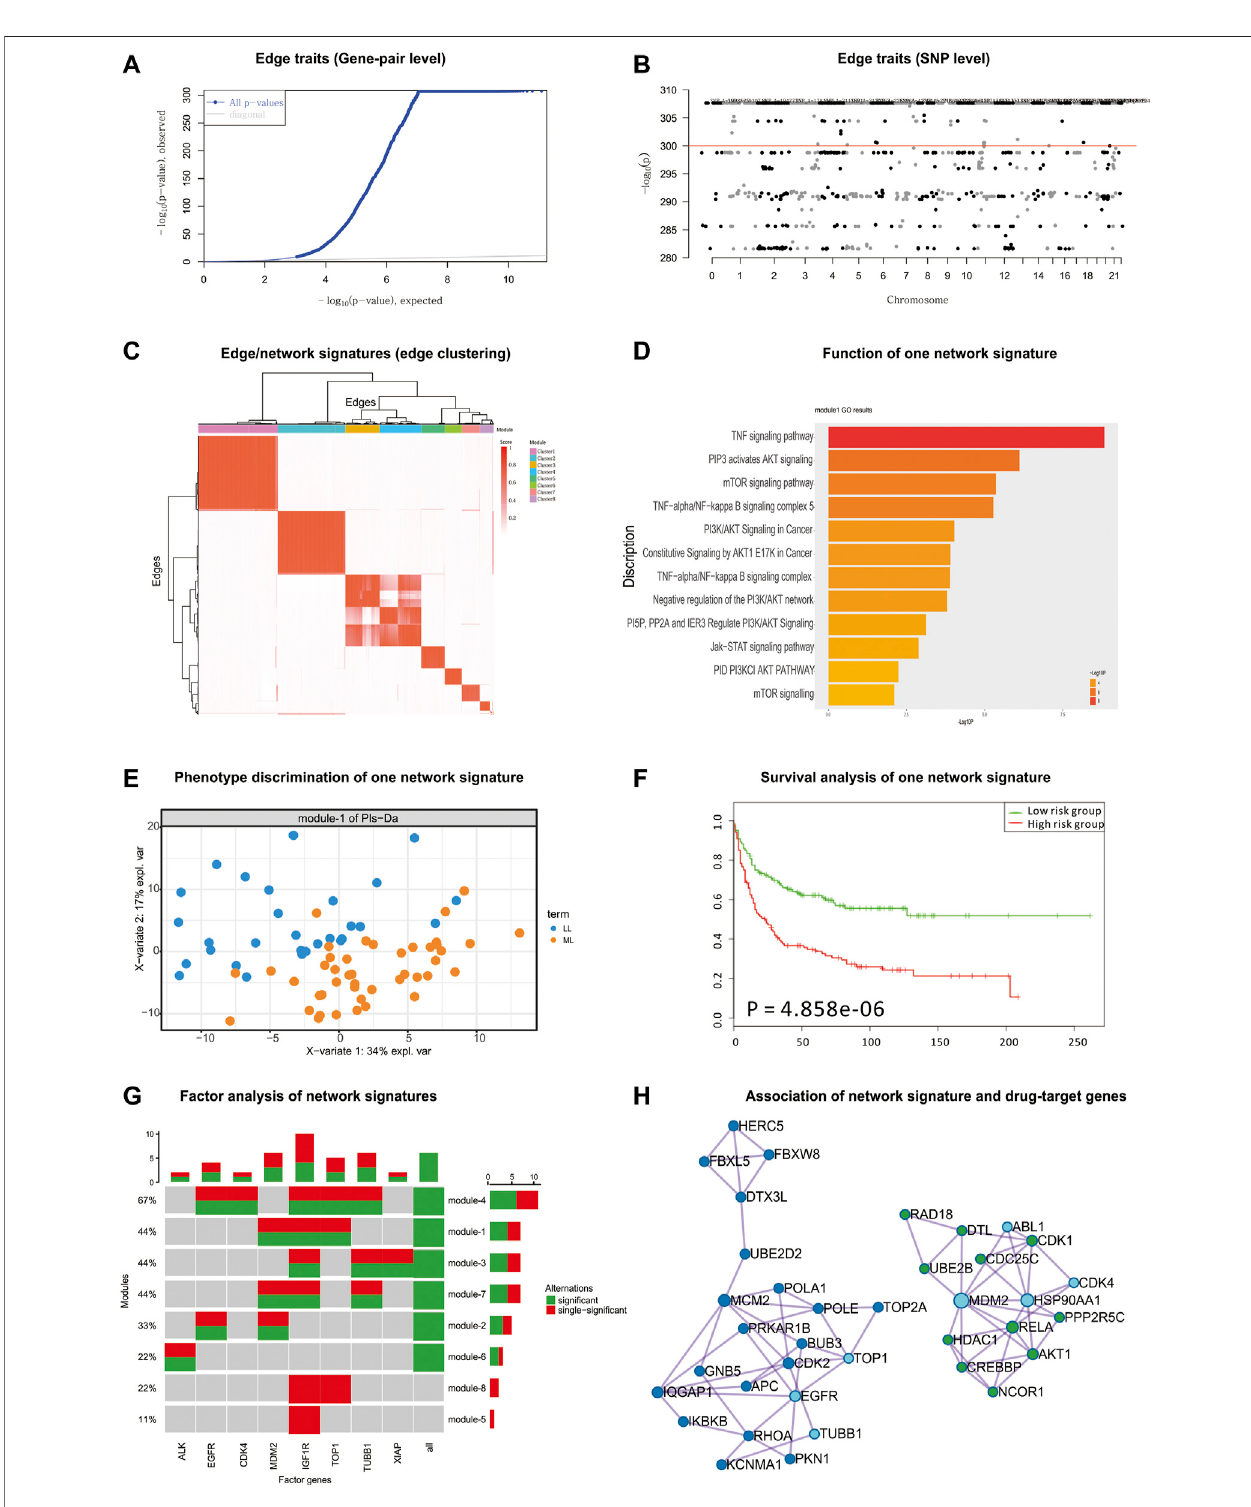
FIGURE4 | nQTL analysis results from CCLE hematopoietic data. (A) QQ-plot ofedge trait on the gene level. (B) Manhattan plotof edge trait on the SNP level. (C) Edge/network signature from edge/gene-pair clustering. (D) The biological function of one signi fi cantnetworksignature. (E) PLSDA ofone signi fi cantnetworksignature fortwogroupsofpatientswithmyelogenousleukemiaandlymphocyticleukemia(i.e.,M vs. L). (F) Survivalanalysisandvalidationofonesigni fi cantnetworksignature. (G) CCA ofnetworksignatures and drug-targetgenes. (H) Association among networksignature genes and drug-targetgenes on the STRING network, where nodes in dark blue and green are two groups of signature genes and nodes in light blue are drug-target genes.